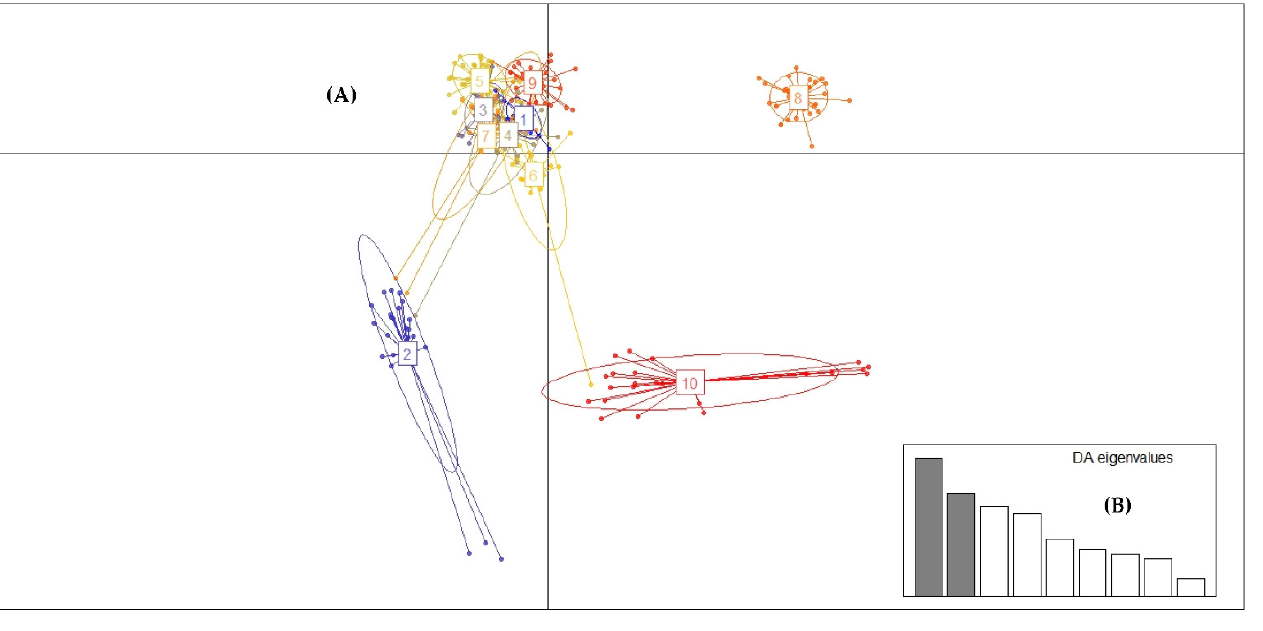
Figure 11. Analysis of the population genetic structure of G. avellana using discriminant analysis of principal components (DAPC) based on EST-SSR data. ( A ) Graph shows the formation of ten genetic groups. ( B ) Discriminant analysis eigenvalues. The bar plot of eigenvalues retains 80 PCs that explain 100% of the cumulative variance.